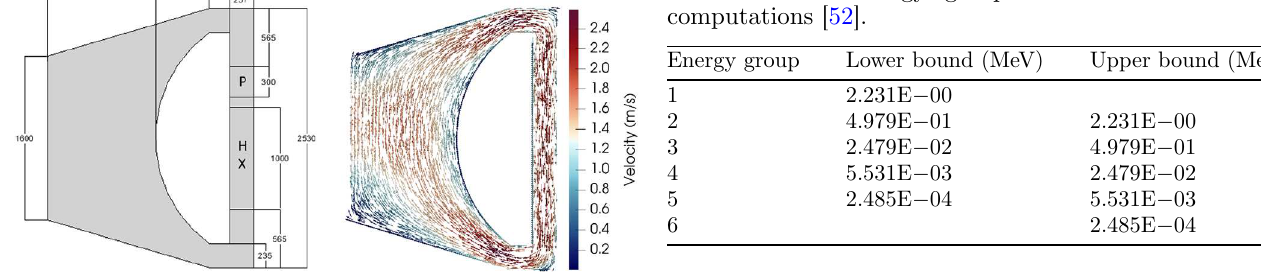
Table 2. The dimensions of the sub-spaces used for the approximation of the fields and the projection of the equations. Field dim. Field dim. Field dim. Field